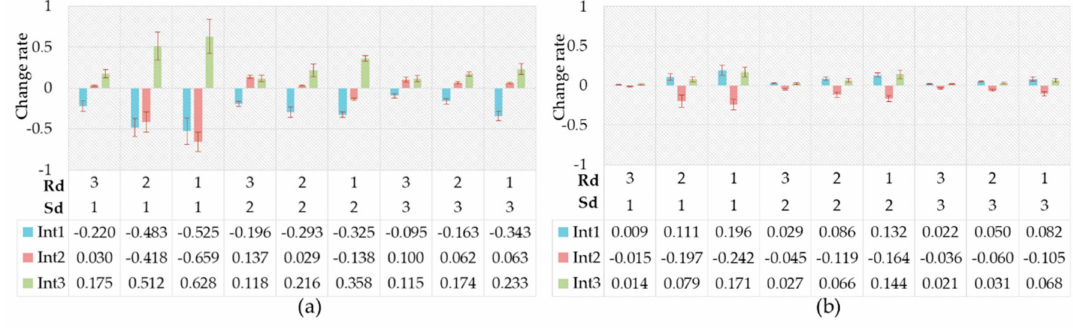
Figure 15. Change rates of driving intention probability. ( a ) Caused by anger; ( b ) Caused by surprise.